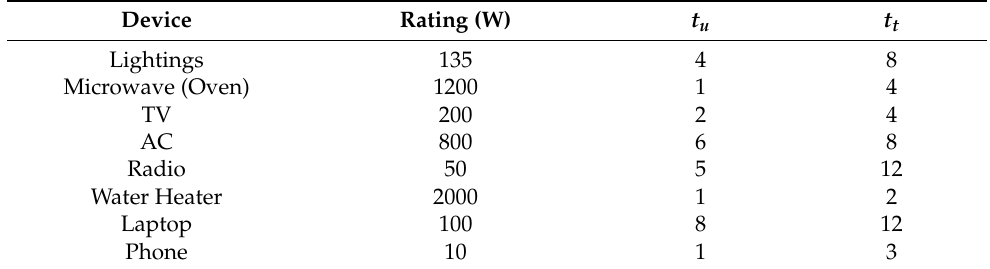
Figure 4. Energy satisfaction (ES) with the proposed SV load allocation using the same or less en- ergy than real REDD [31] database vs. ES satisfaction using REDD [31] database.